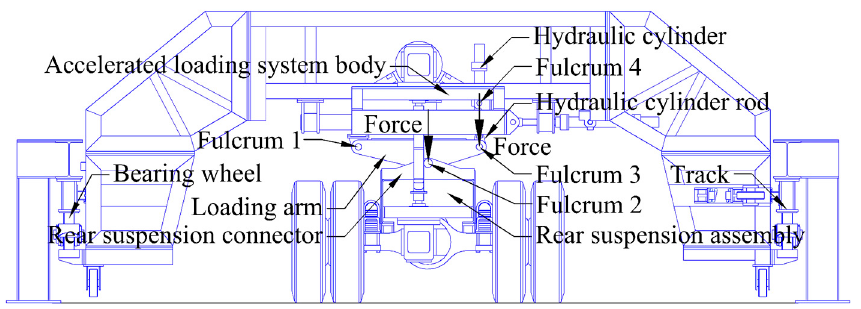
( b ) Figure 7. Relation between the hydraulic pressure and static axle load. ( a ) Load of each tire. ( b ) Each axle and total axle. In the virtual prototype model, the pressure of the hydraulic cylinder was selected as 8 MPa, 9 MPa, 10 MPa, 11 MPa, and 12 MPa. Table 2 is obtained by comparing the simu- lated static axle load with the measured static axle load.